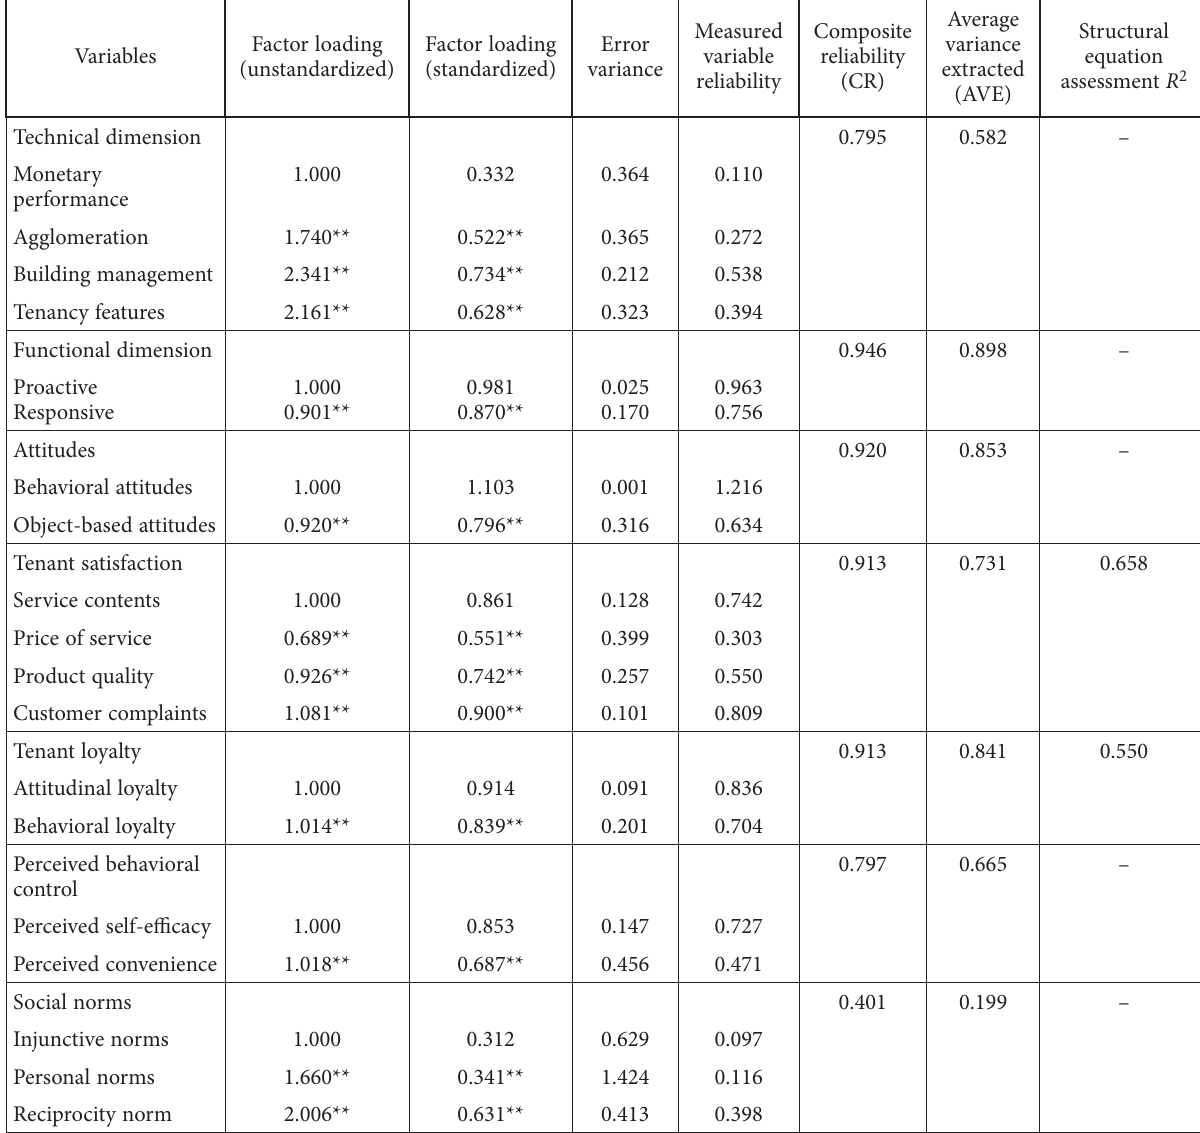
Table 2. Analysis of reliability, factor loading, and average value extracted of the questionnaire